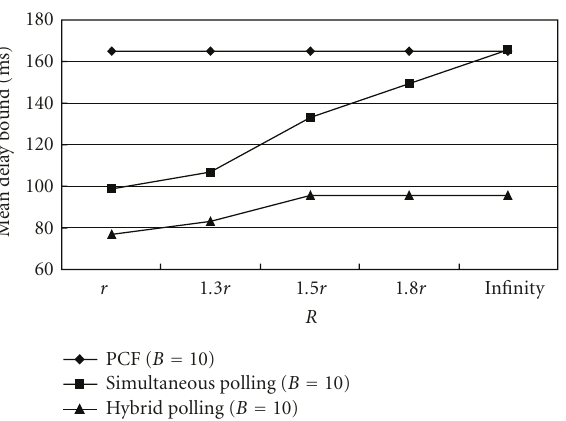
Figure 5: Mean delay bounds when the medium tra ffi c load ( B = 10) is imposed on IEEE 802.11a wireless LAN with 20 STAs.